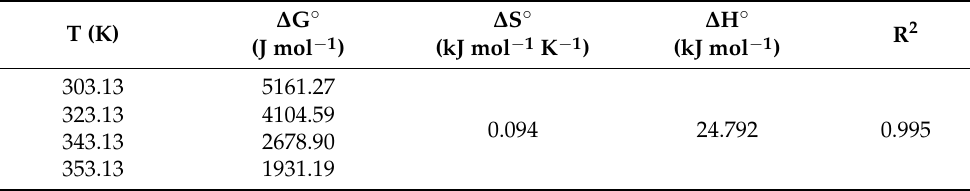
Table 3. Thermodynamic parameters for MO adsorption on AS.